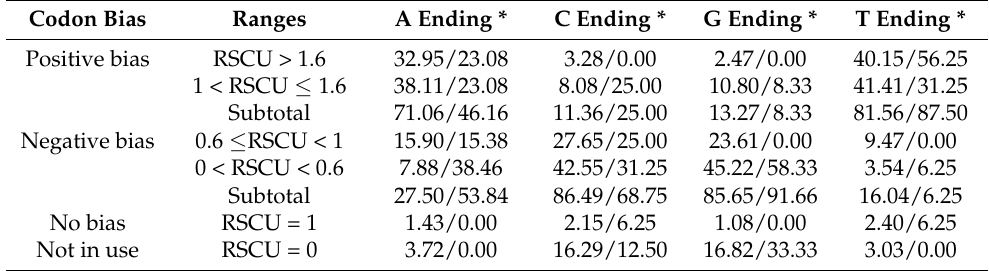
* In percentage number format, with genome data before the slash “/” and psbA gene data after the slash